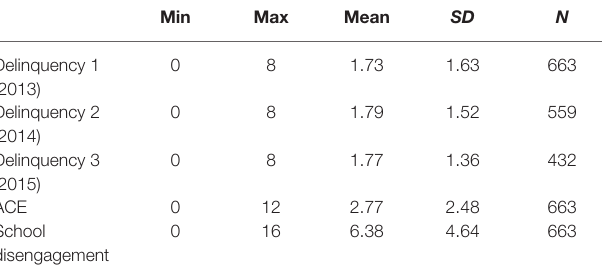
TABLE 2 | Descriptive statistics of the